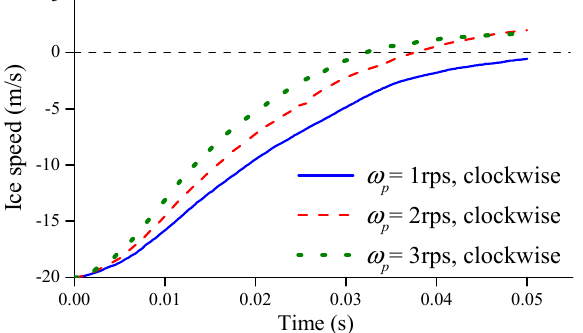
Figure 19. Time series of ice speed in the x direction based on simulations with different rotation speeds for clockwise rotation.